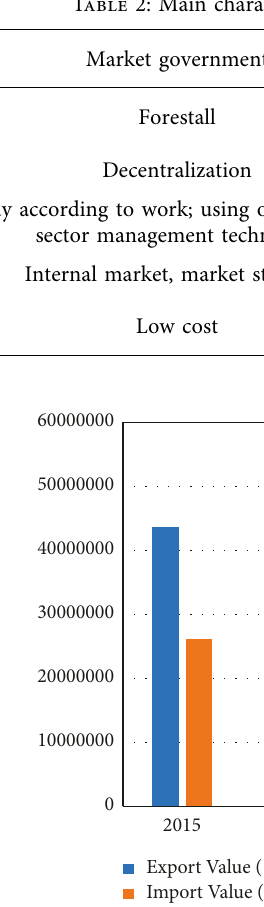
Table 2: Main characteristics of the four new government governance models.